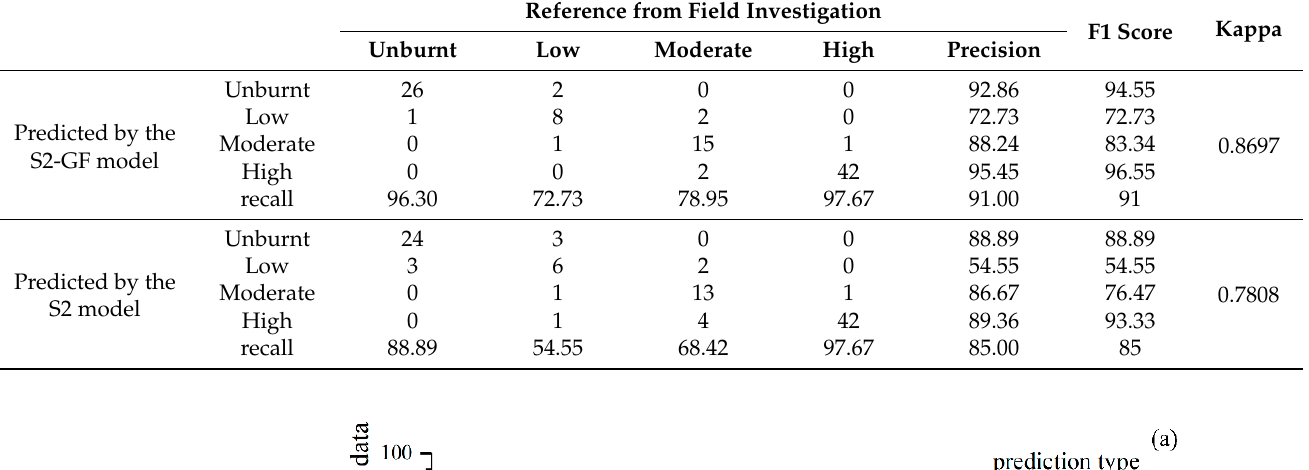
Table 7. Confusion matrix and accuracy statistic of the S2-GF model trained with the combination of S2 and GF series data and the S2 model trained without GF data.